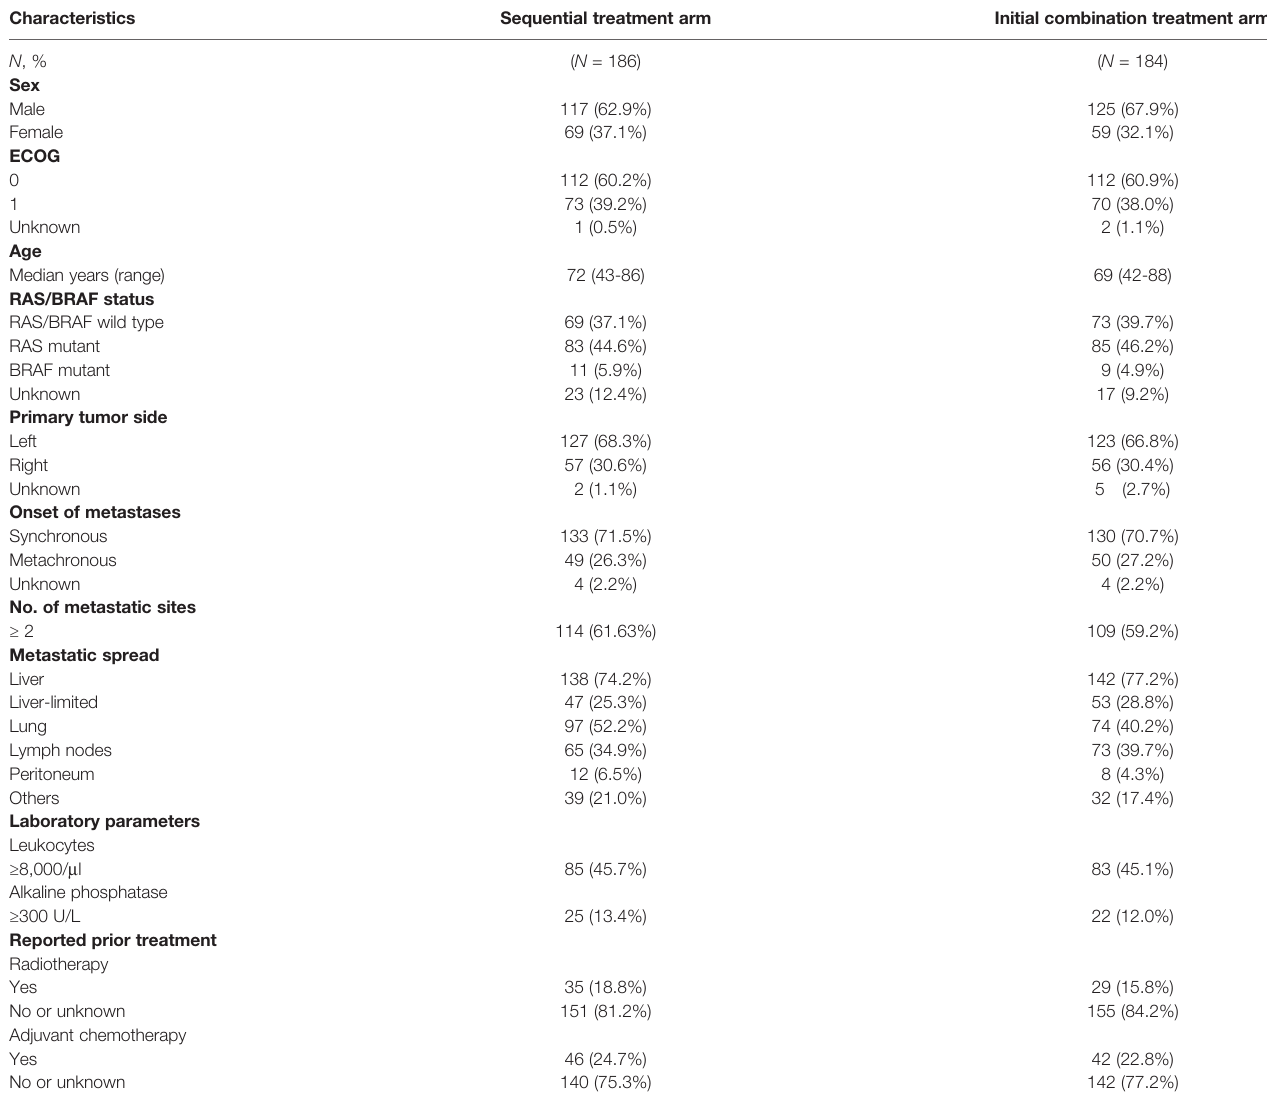
TABLE 1 | Patient and tumor characteristics in patients assessable for early response parameters.